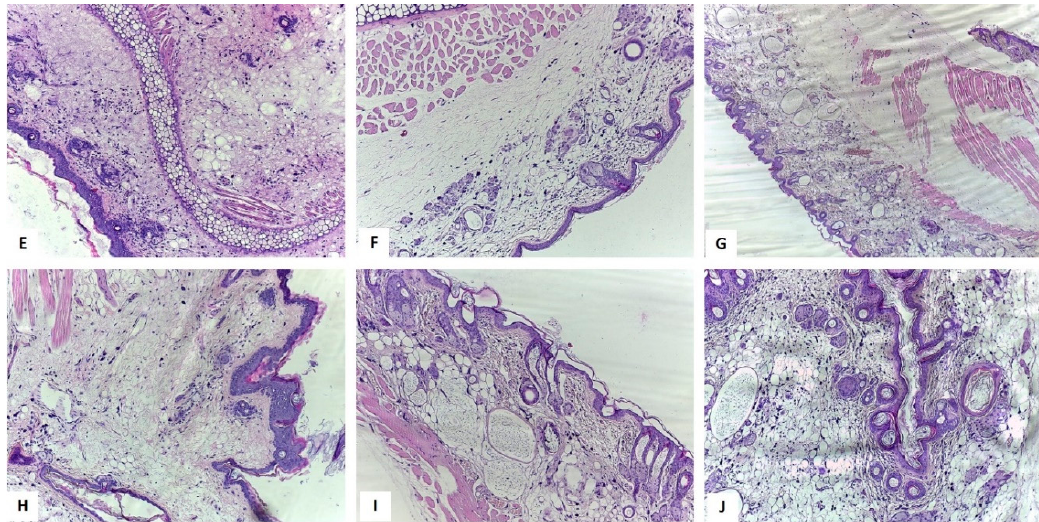
Figure 8. Histological aspects of the skin H-E stain, E : Blank hydrogel group, ob. 10× – the sample displayed inflammatory cells distributed in the entire dermis and massive interstitial edema; F : ZnCl 2